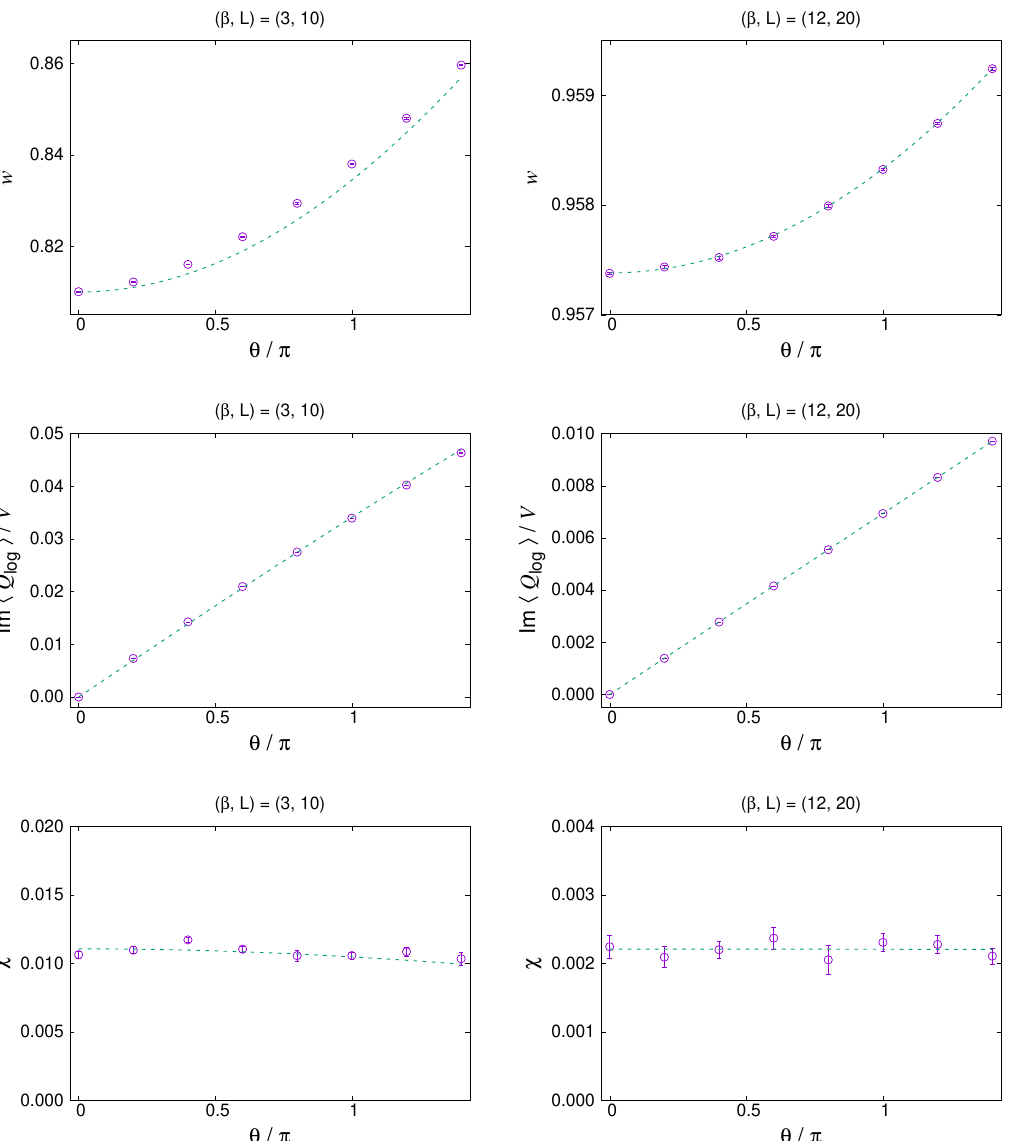
Figure 12 . The results for various observables obtained by the CLM for the punctured model with the log de(cid:12)nition Q log . The average plaquette (Top), the imaginary part of the topological charge density (Middle), the topological susceptibility (Bottom) are plotted against (cid:18) for ( (cid:12); L ) = (3 ; 10) (Left) and (12 ; 20) (Right). The exact results for the same ( (cid:12); L ) are shown by the dashed lines for comparison.